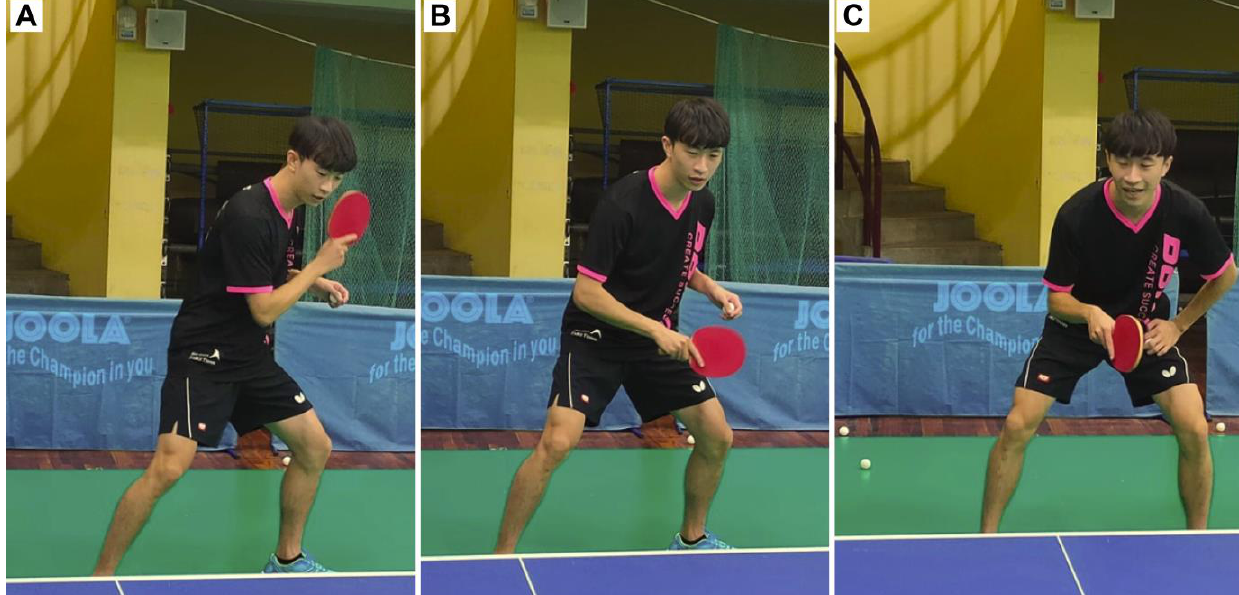
Figure 17. ( A ) Chop action (start). ( B ) Chop action. ( C ) Chop action (end). The chop action from the start to the end.